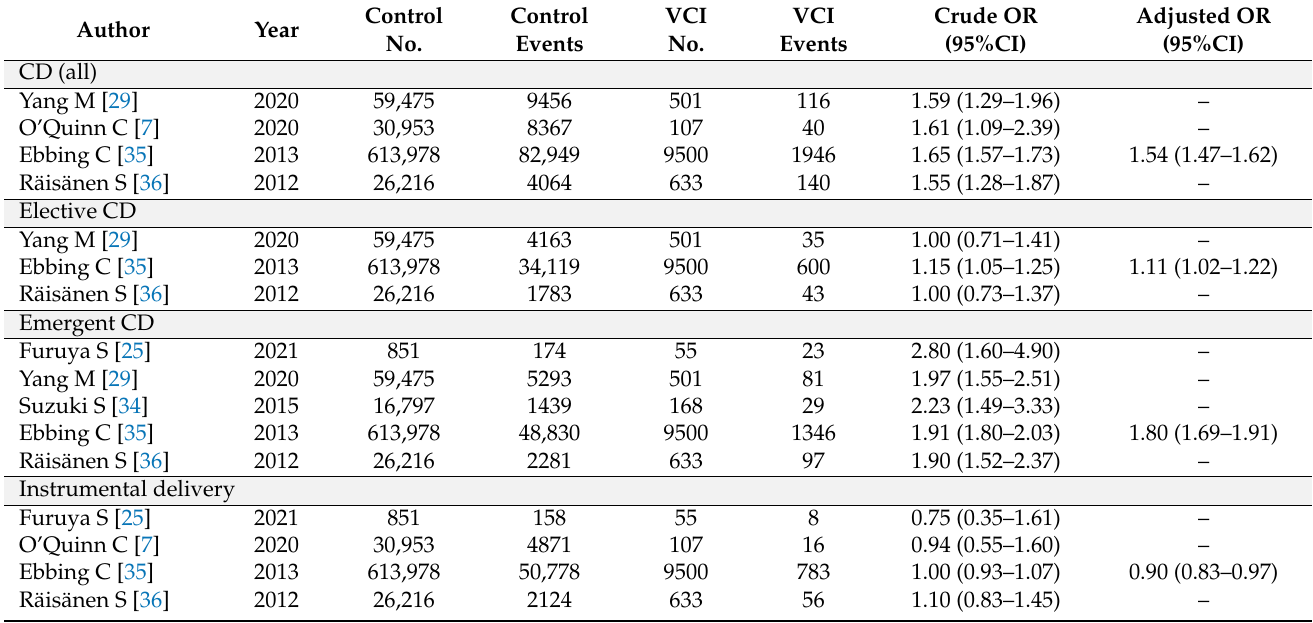
Table 3. Effect of VCI on delivery